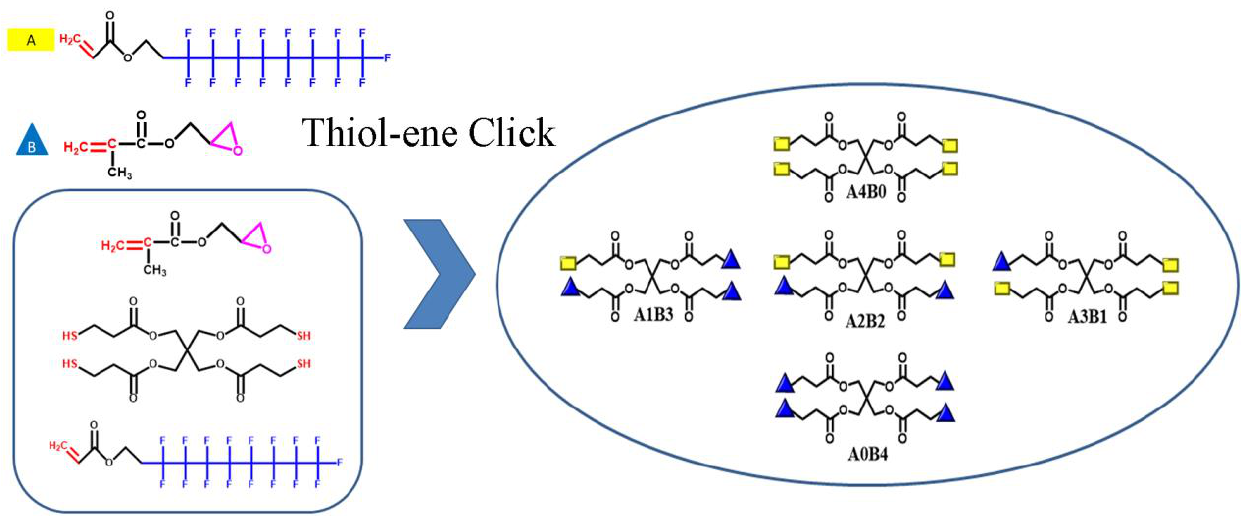
Figure 1. Scheme for preparation of fluorinated epoxy via thiol-ene click method.